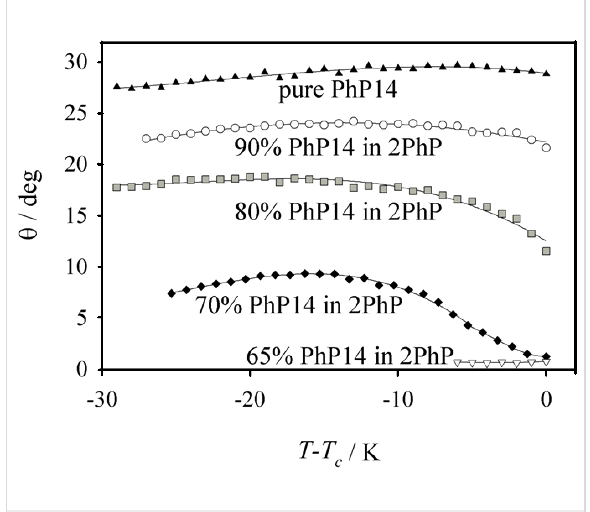
Figure 7: Tilt angle vs temperature difference to the phase transition temperature for pure PhP14 (filled triangles), 90% (open circles), 80% (gray filled squares), 70% (filled diamonds) and 65% (open triangles) PhP14 in 2PhP . The tilt angle is reduced successively with increasing mole fraction of the short component 2PhP . In this system a concen- tration-induced phase transition from SmC to SmA occurs.